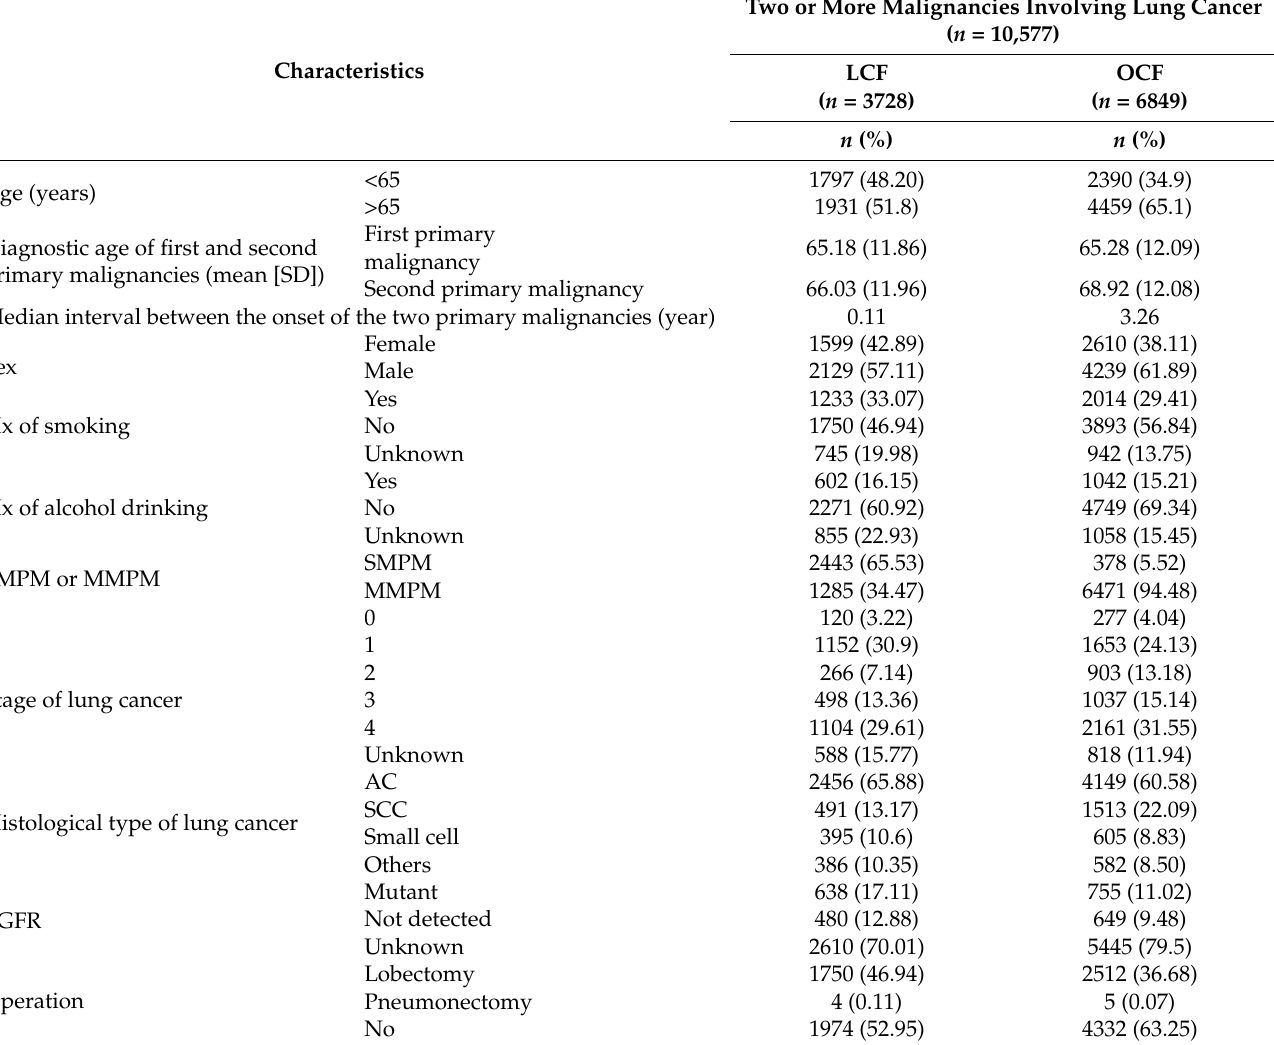
Table 1. Baseline characteristics of patients with multiple primary malignancies involving lung cancer.